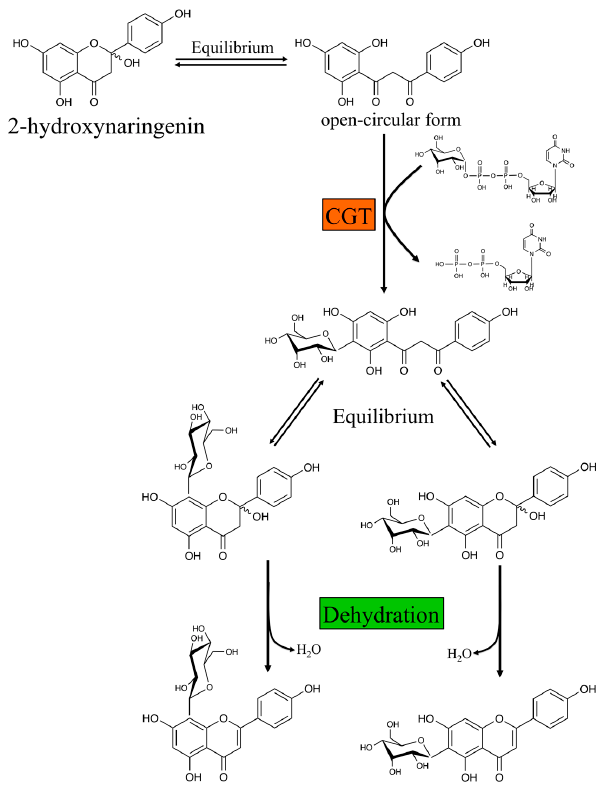
Figure 4. A proposed mechanism for the conversion of 2-hydroxynaringenin to vitexin